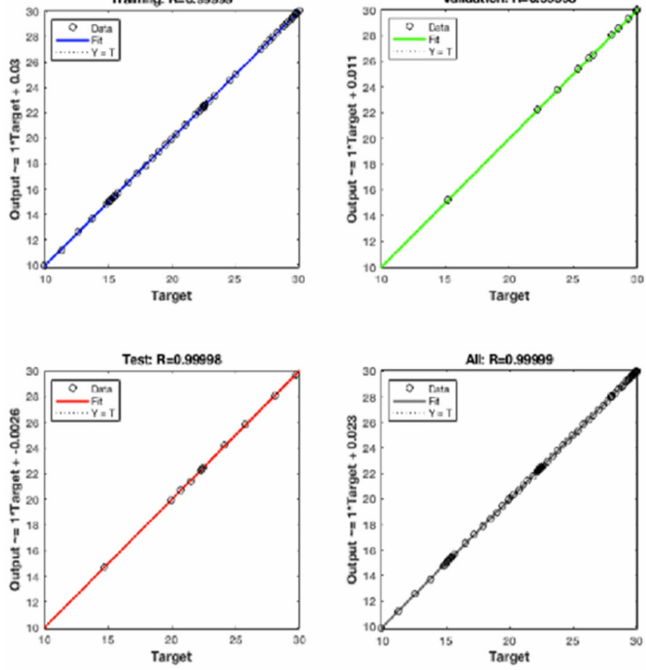
Figure 8. Model linear fitting in training and testing model